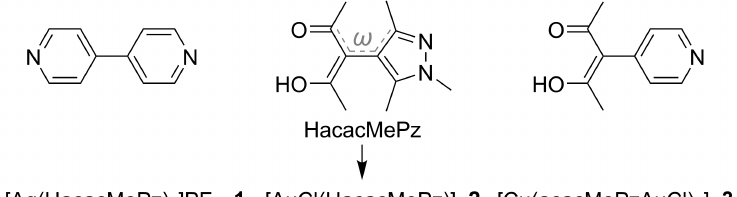
Figure 1. Structures of homoditopic 4,4 (cid:48) -bipyridine ( left ) and heteroditopic ligands